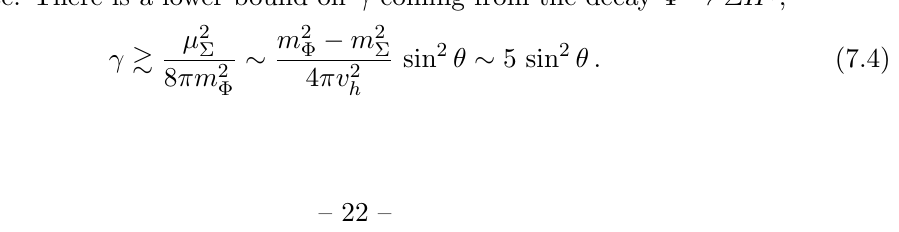
before decay till at least x & 10 3 . We therefore make the approximation that (cid:9) has